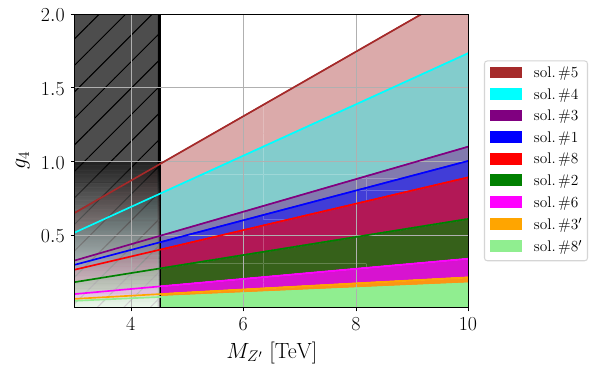
Fig. 10 Upper limits on the U ( 1 ) (cid:3) gauge coupling g 4 as a function of the Z (cid:3) mass (47) for the models in Table 5. The black region is excluded by direct searches in dimuon and dielectron spectra [14]. For lower values of g 4 , the bounds become model-dependent as indicated by the lighter color, see main